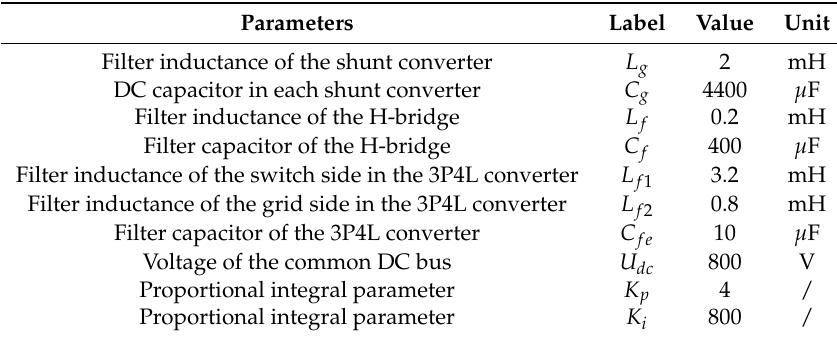
Table 1. Parameters of the filter.